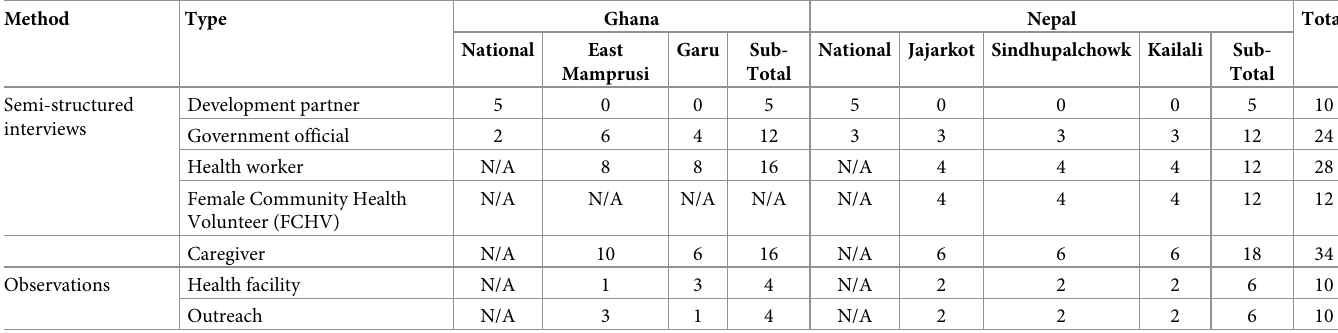
Table 1. Data collection methods, types of participants, and observation